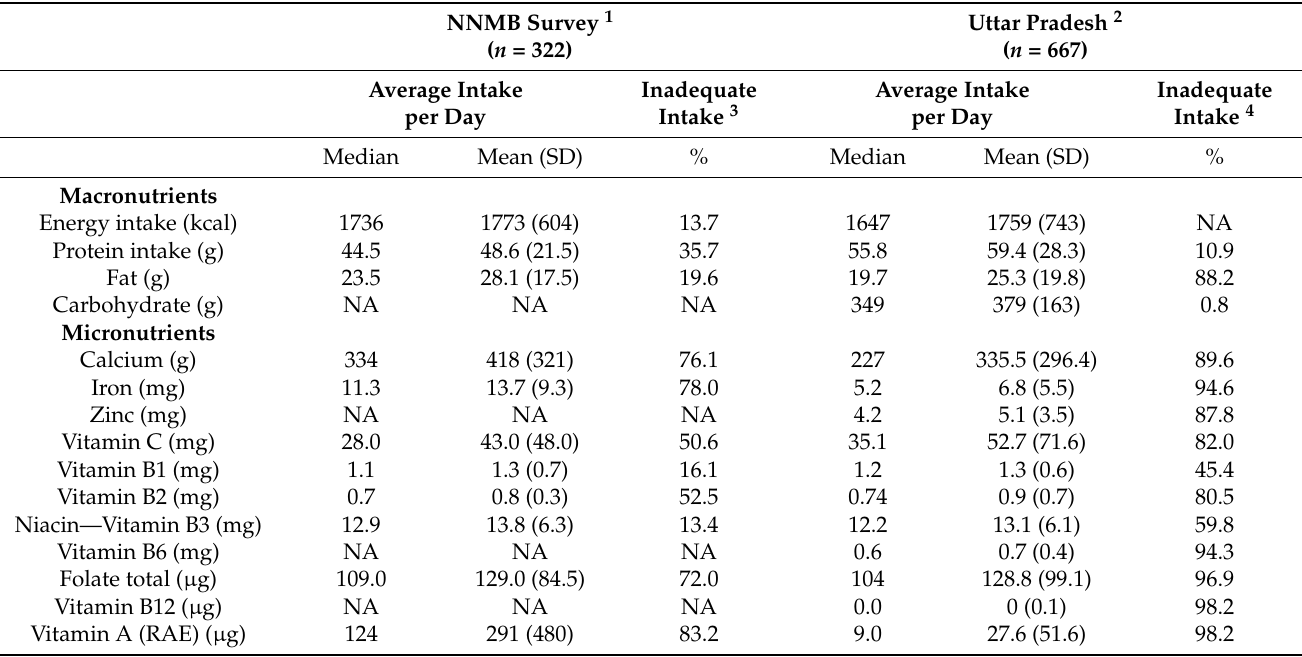
Table 1. Macro- and micronutrient